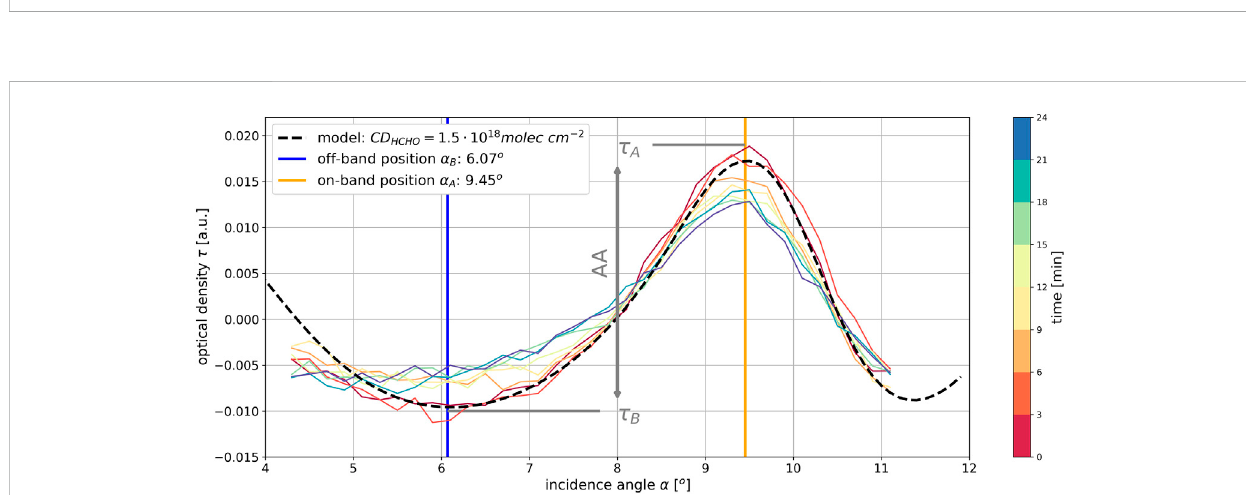
FIGURE 3 IFPICS interferogram of a HCHO gas cell, i.e., the optical density τ as a function of the FPI incidence (tilt) angle α , where the color scale indicates the time after initial heating of the HCHO gas cell. Since the gaseous HCHO repolymerizes to PFA during gas cell cooling, a decrease in AA signal (difference between τ A and τ B , see Section 2.3) is observed, which is indicated by the different colored lines. Black dashed line: model simulation for a HCHO CD of 1.5 × 10 18 molec cm − 2 . The measurement and the model simulation are normalized to their respective mean value. The vertical lines show the chosen on-band position α A of 9.45 ° (orange) and off-band position α B of 6.07 ° (blue) obtained from the comparison of measurement and model